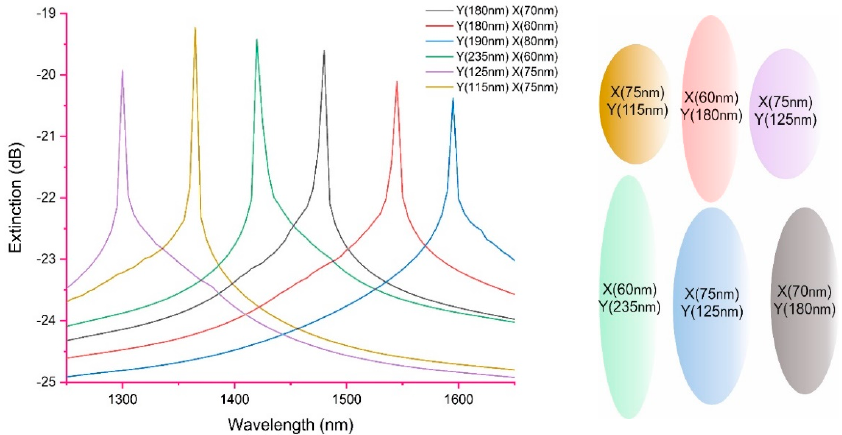
Figure 4. Typical calculated spectral shifts of the extinction of the LSP as a function of the spatial geometry and size of the nano-blocks, using the measured variation in the minor and major axes, for a Ge-SiO2-Au tri-layer with a surrounding index of 1.367. Along with showing the relative changes of shape for the nano-spheriods that generate the spectrums.